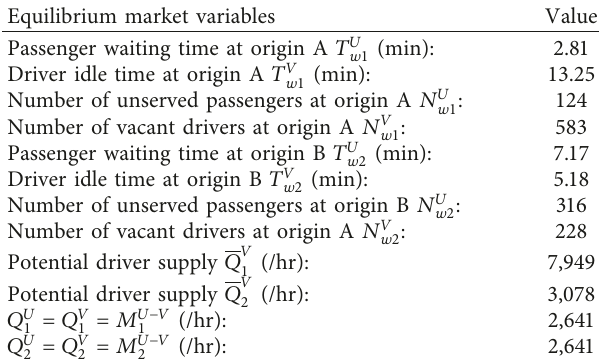
( θ U � 1 , θ V � ( 1/6 . 6702 )) . (e) Evolution of w Table 3: Two-node disaggregate market equilibrium. Equilibrium market